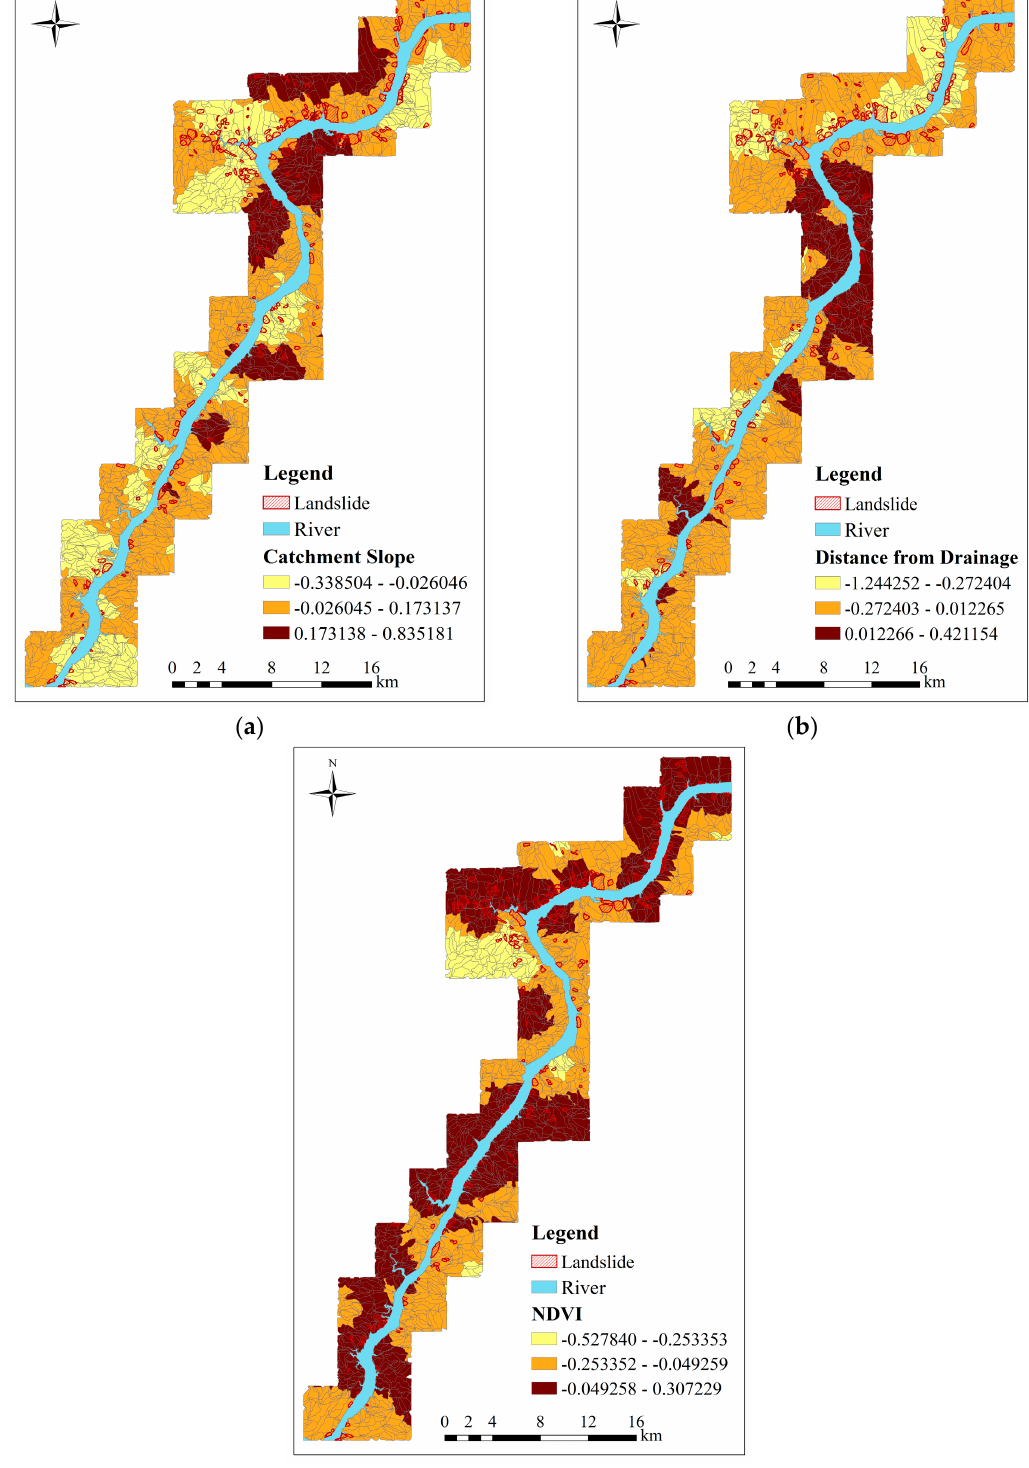
Figure 12. The GWR coefficient values and classification maps of environmental factors. ( a ) Catchment Slope; ( b ) the distance from drainage; ( c ) NDVI.